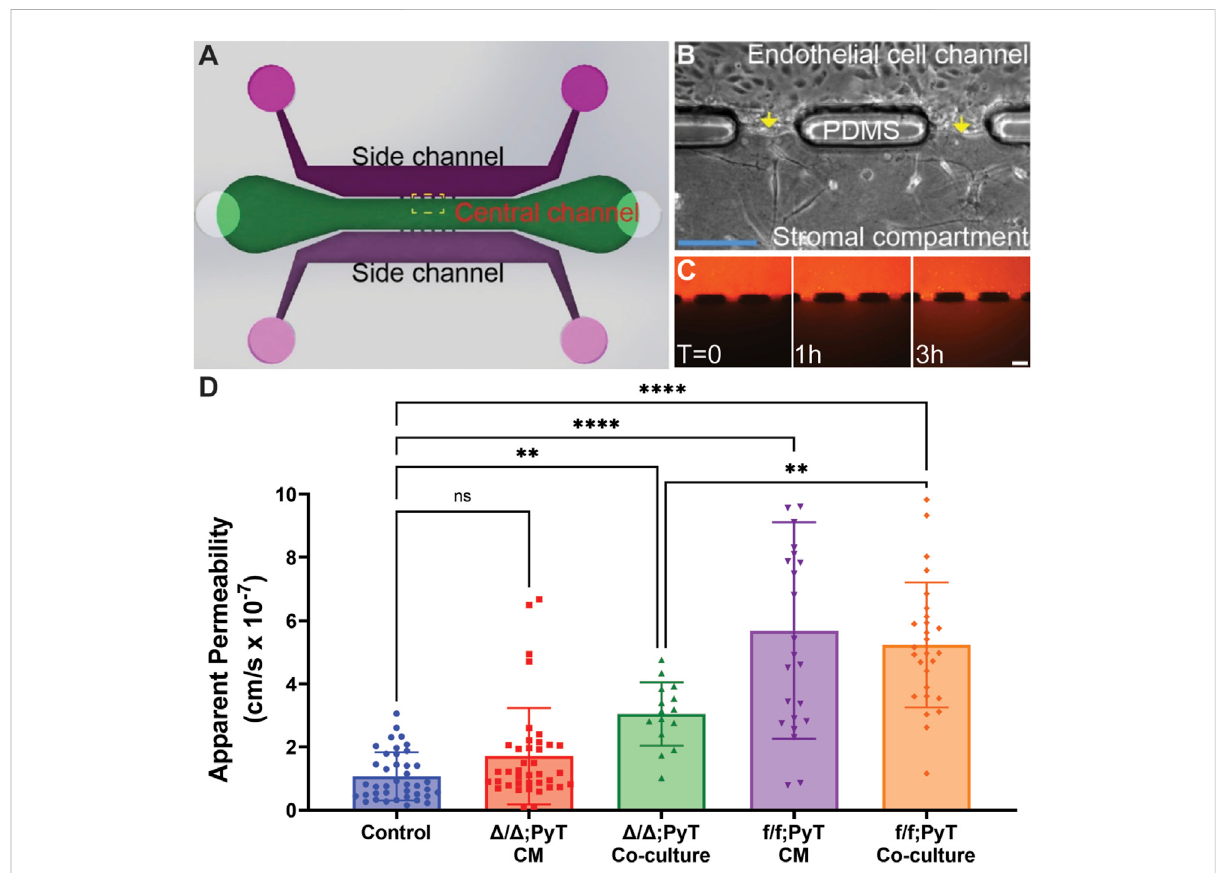
FIGURE 2 Compartmentalized micro fl uidic device for vascular permeability measurements. (A) Schematic of microtissue analogue micro fl uidic device. (B) Dashed boxed region in (A) depicting endothelial cell-lined microchannel laterally adjacent to a central stromal compartment containing fi broblastsembeddedina3-DtypeIcollagengel.Arrowsdepicttheendothelial-stromalcompartmentinterface. (C) TexasRed-conjugatedDextran (70 kDa) dissolved in media served as a fl uorescent tracer and was introduced into the MEEC-lined channel. The fl uorescent tracer passes throughtheendothelialmonolayerofthemicrovesselanalogueandentersthestromalcompartmentbydiffusion.Scalebarsare50 µm. (D) Changes in fl uorescence intensity within the stromal compartment were used to calculate apparent vascular permeability of vessels in the presence of conditioned media (CM) or co-cultured with CAFs — with and without Cxcl12 gene deletion. Reported values represent the mean ± standard deviation, with n ≥ 3 biological replicates and at least 15 apertures analyzed for each condition: * p ≤ 0.05, ** p ≤ 0.01, *** p <